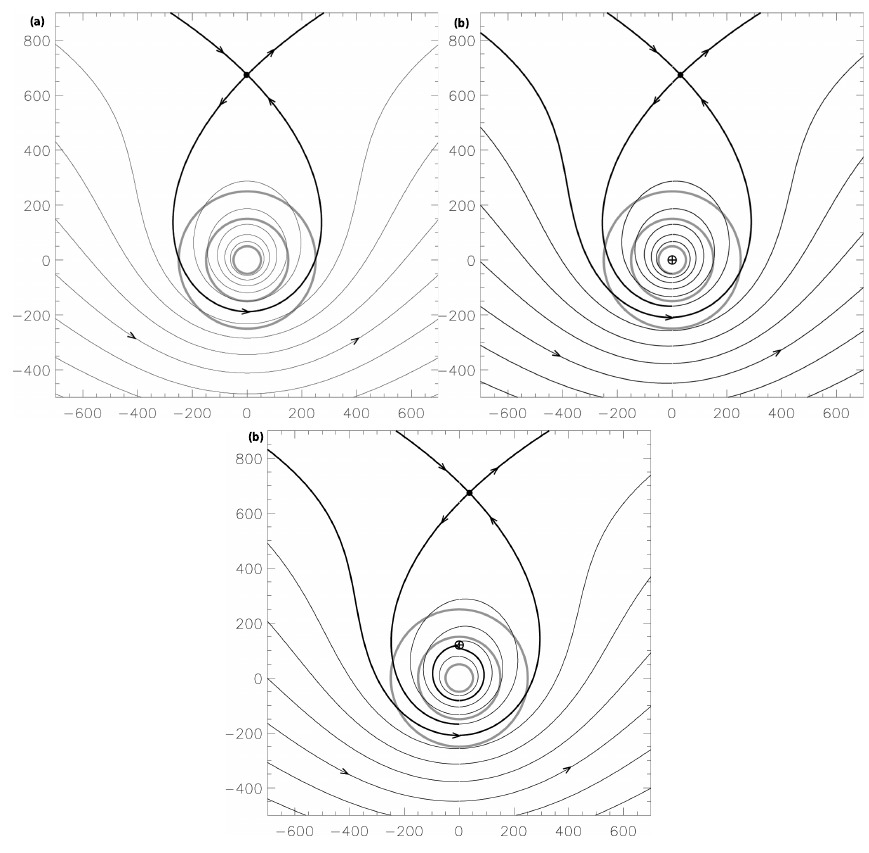
Fig. 7. (a) Streamlines of a stationary, cyclonic, non-divergent point vortex with a circulation of 33.7 × 10 5 m 2 s − 1 (Cat3, see Table 1) in 5ms − 1 westerly background flow. The strength of the vortex and the storm-relative environmental flow are chosen to be similar to the idealized numerical experiment at 2km height (cf. Fig. 3). The streamlines passing through the stagnation point (black dot), the flow’s manifolds, are highlighted. The horizontal scale is inkm. The gray concentric circles denote radii 50km, 150km, and 250km, respectively. (b) Same as (a) but for a weakly convergent point vortex with D = − 1 . 5 × 10 5 m 2 s − 1 . The mass sink is marked by the crossed circle. (c) Same as (b) , but for a mass sink that is displaced 120km to the north of the center. The emerging closed streamline, reminiscent of the limit cycle found in the idealized numerical experiment (cf. Fig. 3), is